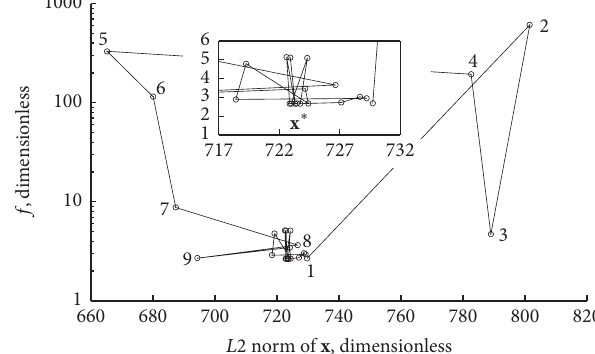
Figure 6: Minimum search path for case 4 . The numbers indicate the order in which 𝑓 was evaluated. An inset shows the behaviour of 𝑓 around x ∗ , evaluations of 𝑓 from 10 to 24. See Table 2 for details of the cases.